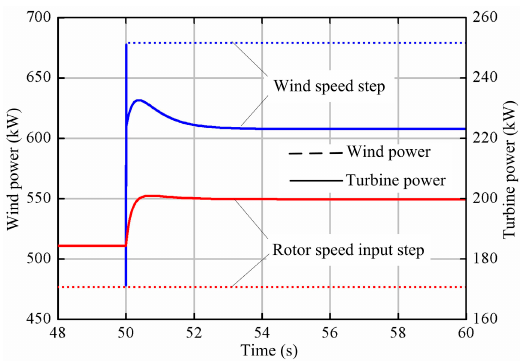
Figure 15. Wind power and turbine power.